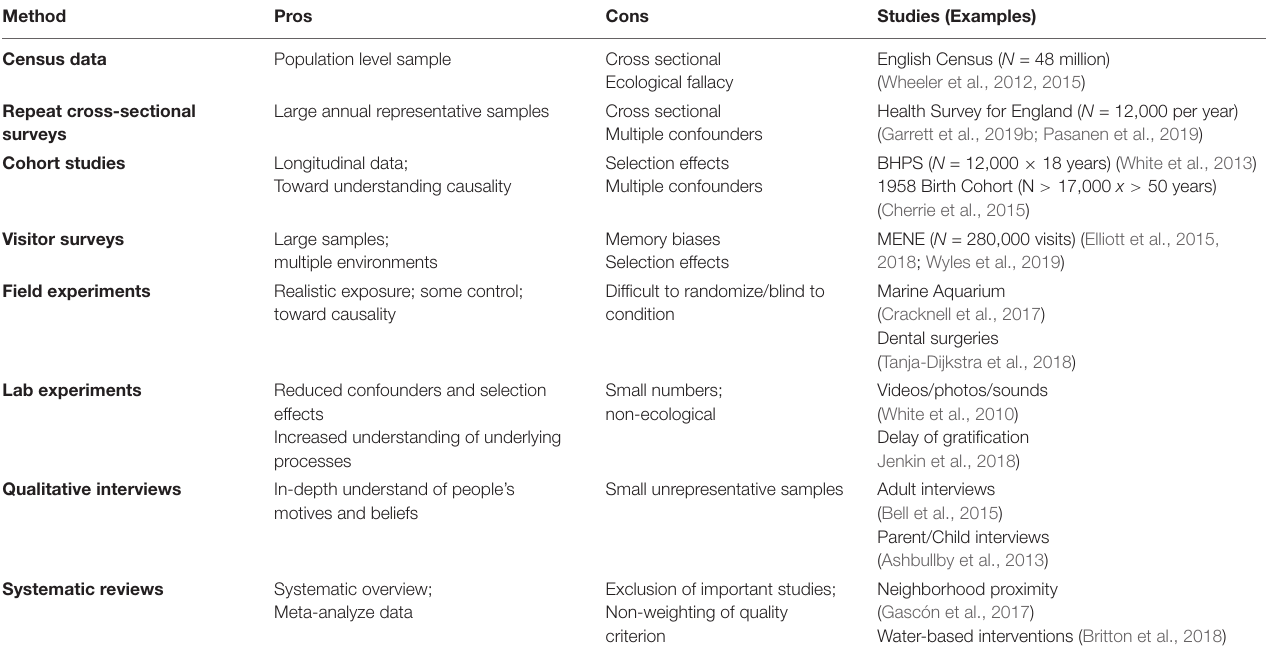
TABLE 1 | Overview of strengths and limitations of different research approaches to exploring health and well-being from blue